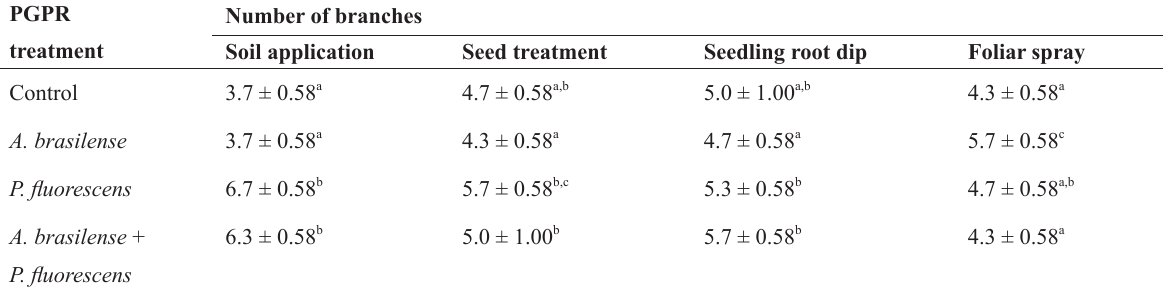
Average of three replicates; ± = SE; Differences between control and treated significant at p= 0.01(Student’s t-test) where superscript of control and treated are different; where superscript same, difference insignificant. Effect of methods of application of single and mixed PGPR on the number of branches in groundnut plants.